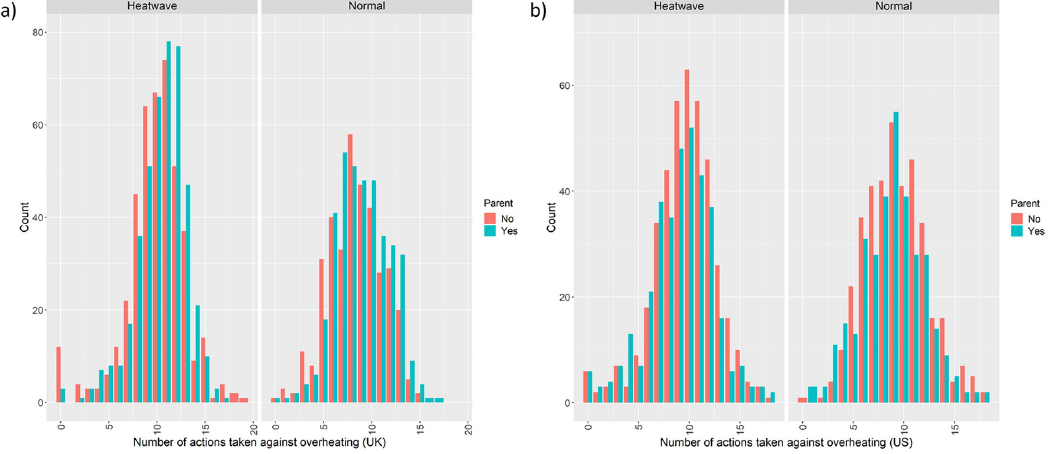
Fig 2. Frequency distribution of the number of overheating actions taken during a heatwave and a normal summer in the UK (a; top panel) and the US (b, bottom panel).